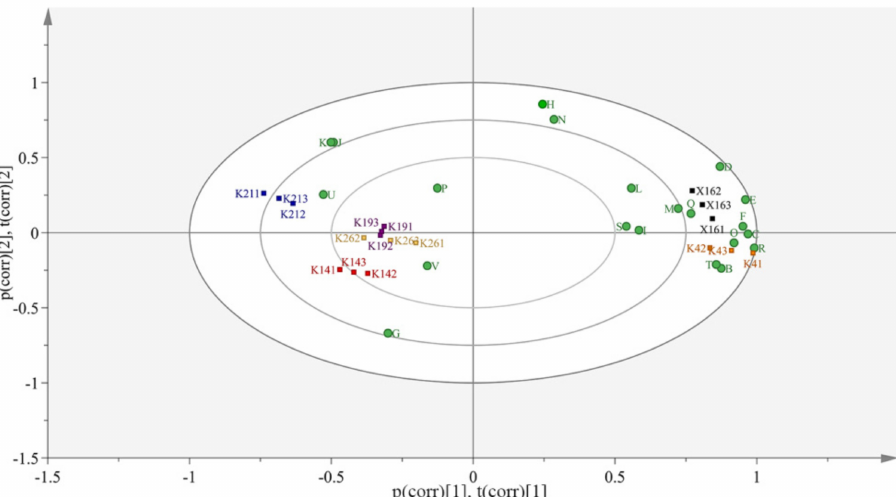
Figure 7. Principal component analysis of aromatic compounds in KFP wine. Abbreviations: